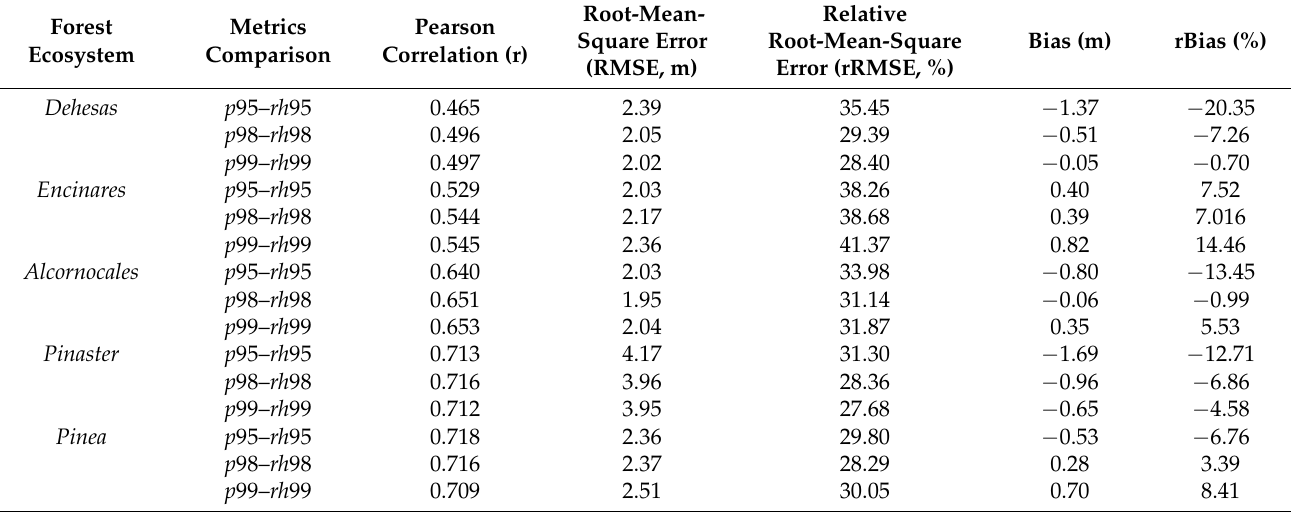
Table 4. Comparison between the 95th, 98th, and 99th percentile ALS-based forest height ( p ) distribution and GEDI relative height ( rh ) metrics in terms of r , RMSE, rRMSE, Bias, and rBias. Forest